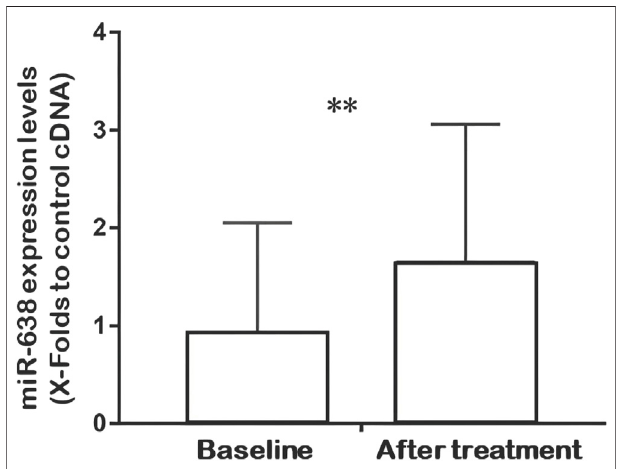
FIGURE 2 | Quantitative real-time fl uorescence polymerase chain reaction (QRT-PCR) analysis of miR-638 expression at baseline and after XZK treatment. Relative expression of miR-638 was raised after XZK treatment. ** p < 0.01. Horizontal lines represent standard deviation.